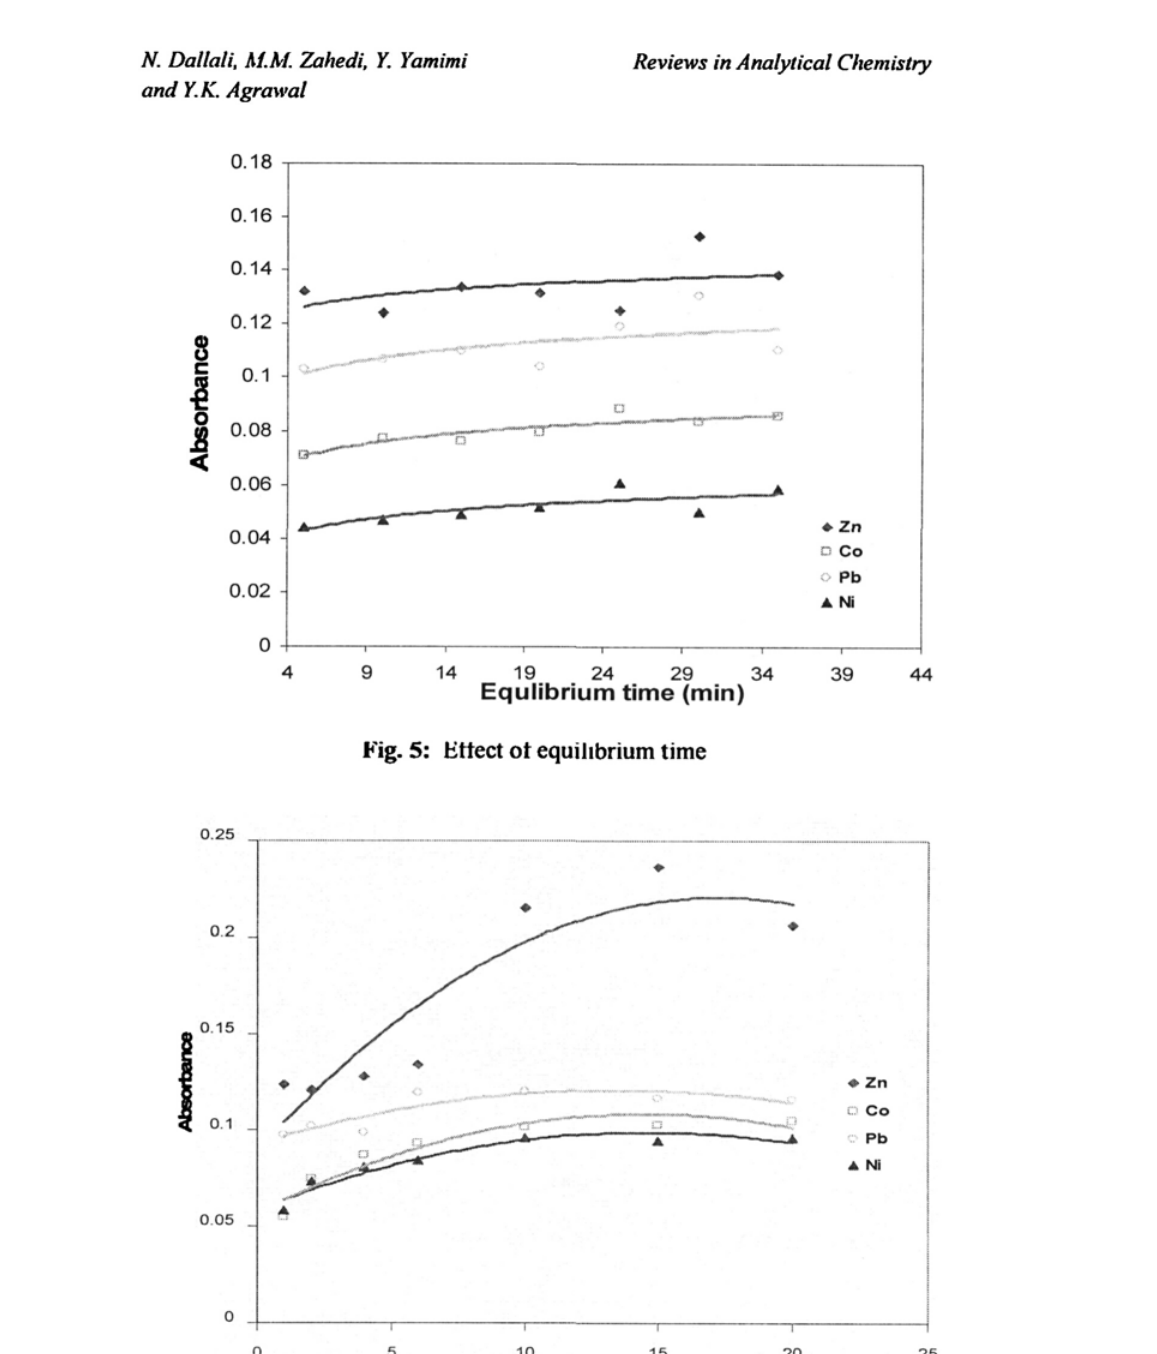
Fig. 6: Effect of centrifugation